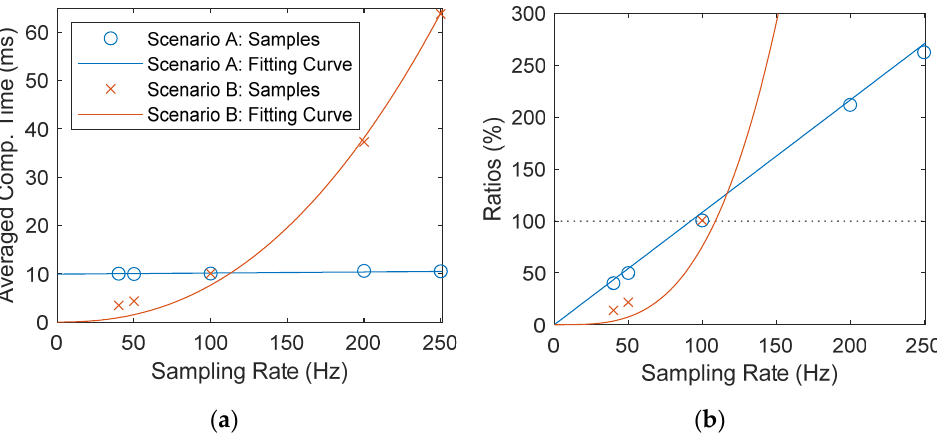
Figure 7. The averaged computation time and percentage spent on computation in each step. ( a ) Averaged computation time; ( b ) ratio in each step.